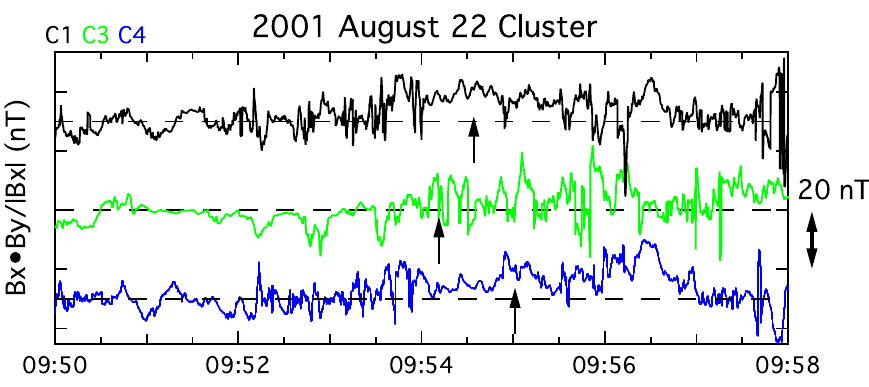
Fig. 5. The paarameter B x B y / | B x | to check for the signature of the quadrupole magnetic perturbation from the Hall current system associated with magnetic reconnection. The arrow below each trace indicates the plasma flow reversal time for that